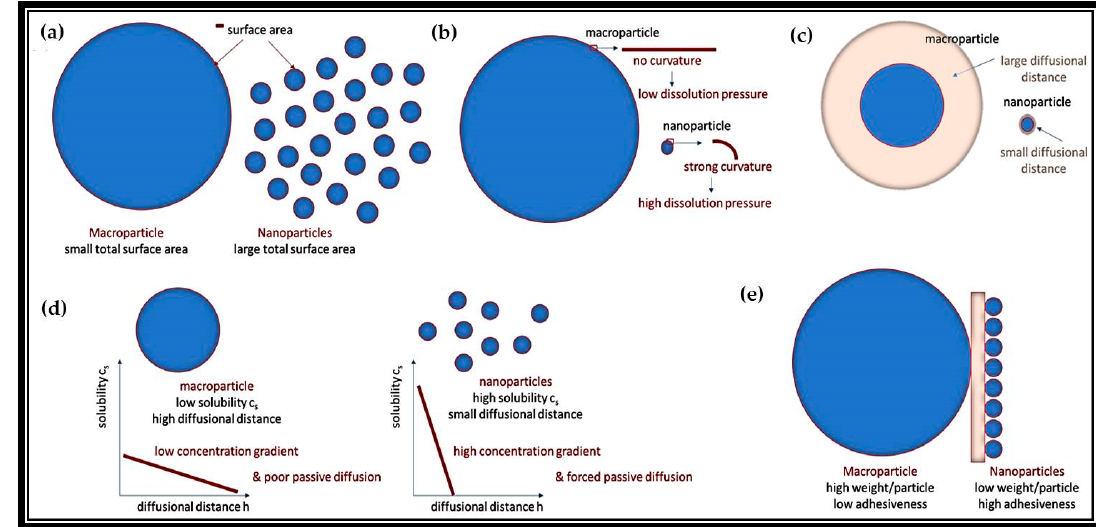
Figure 6. Properties of nanoparticles: ( a ) increased rate of dissolution; ( b ) enhanced saturation solubility; ( c ) decreased diffusional distance; ( d ) higher concentration gradient; and ( e ) improved adhesiveness.